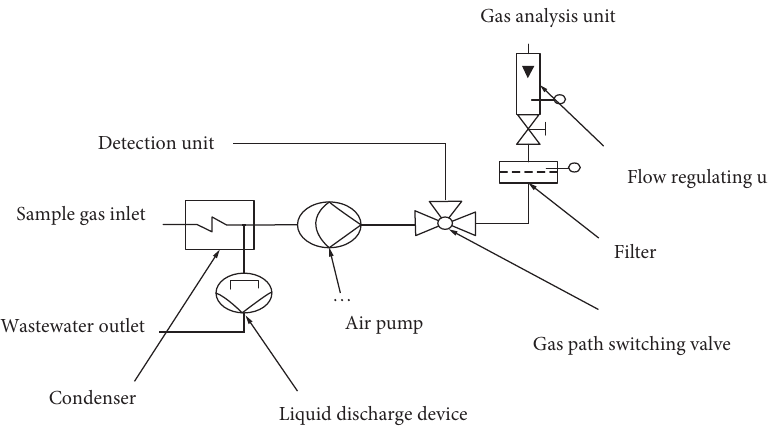
Figure 3: Structural diagram of the pretreatment device. Table 1: Contrastive analysis under different MSE.